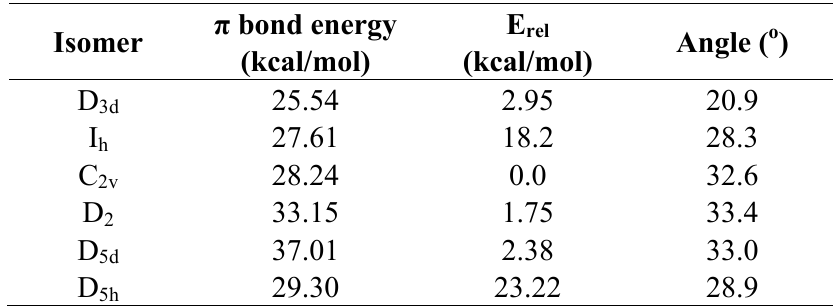
Table 1. Relative data of the six